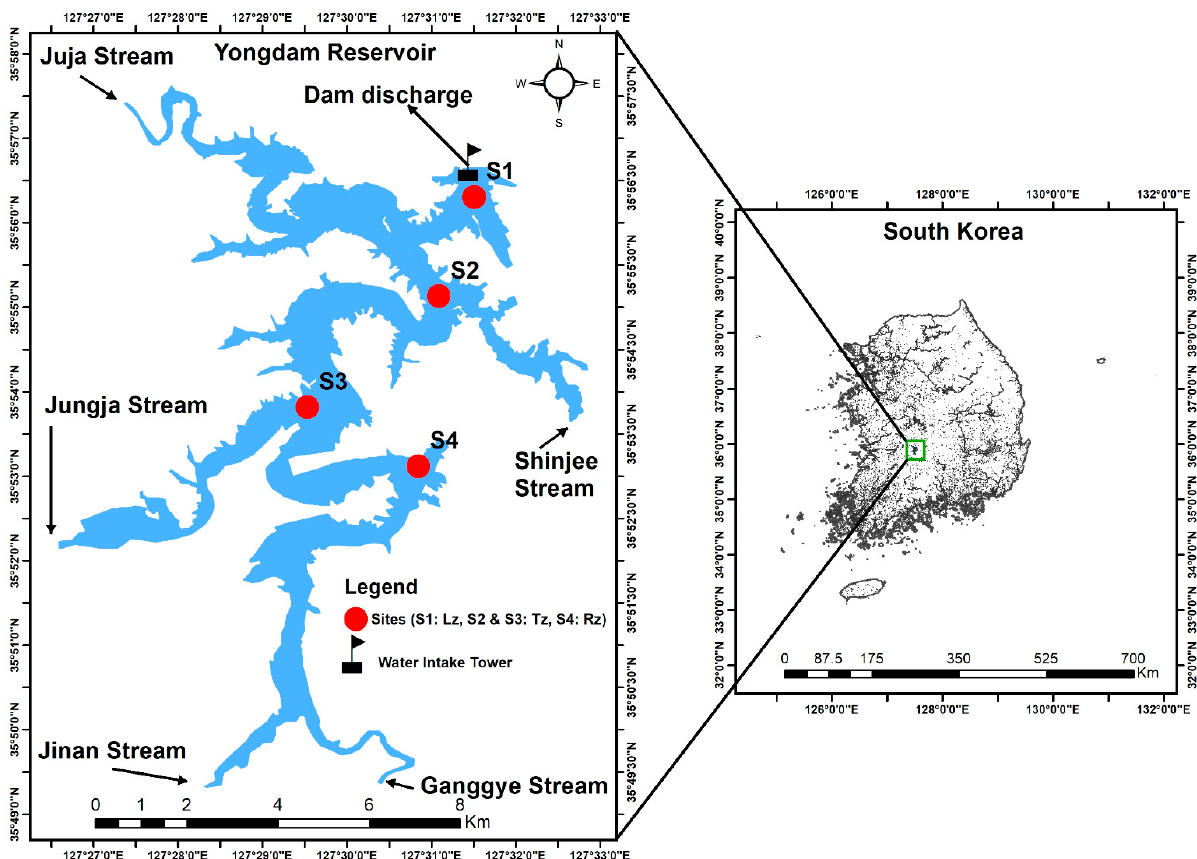
Figure 1. Study area map of Yongdam Reservoir showing four study sites and the location of the water intake tower.